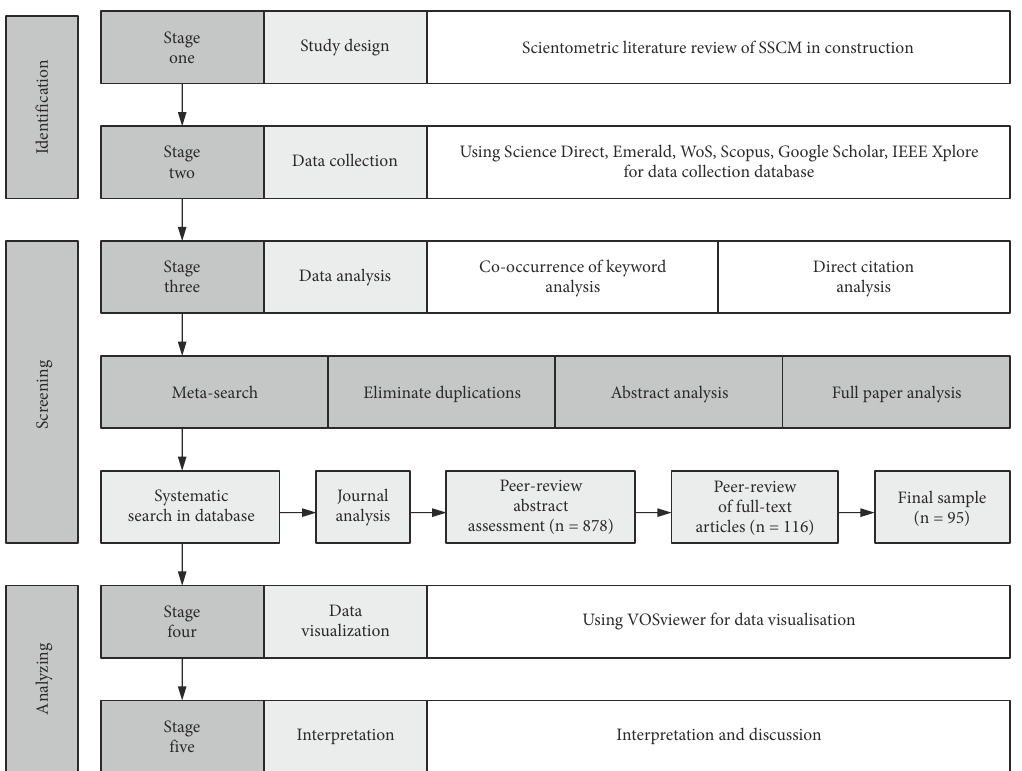
Figure 1. Stages of systematic literature of SSCM in construction industry (compiled by the author using PRISMA